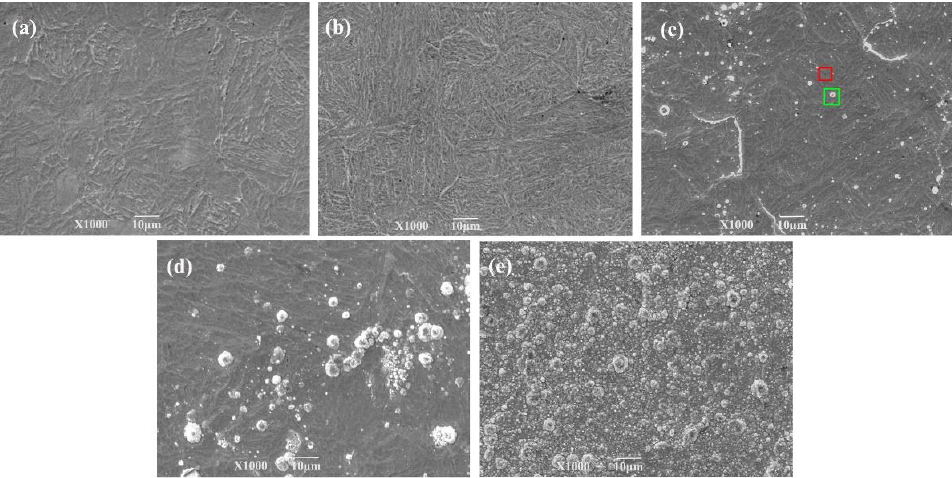
Figure 5. Surface morphology of 1Cr15 stainless steel after ion nitriding treatment: ( a ) 250 °C for 24 h; ( b ) 300 °C for 24 h; ( c ) 350 °C for 24 h (The rectangle is the EDS scanning point); ( d ) 400 °C for 24 h; ( e ) 450 °C for 24 h.